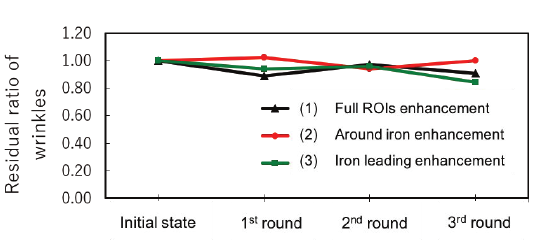
Figure 6. Change in wrinkle residual ratio by trials (a case with a subject who did not gradually decreased the residual